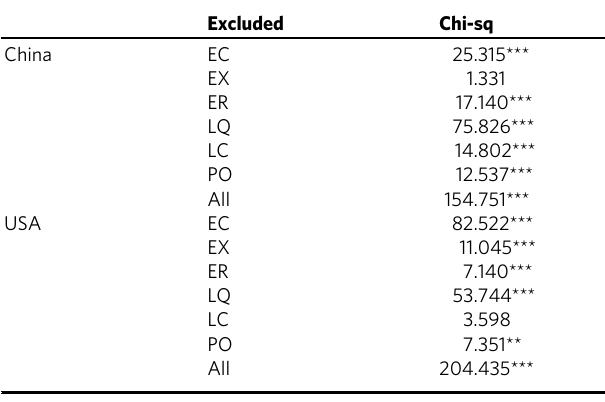
Table 10 VAR Granger causality test